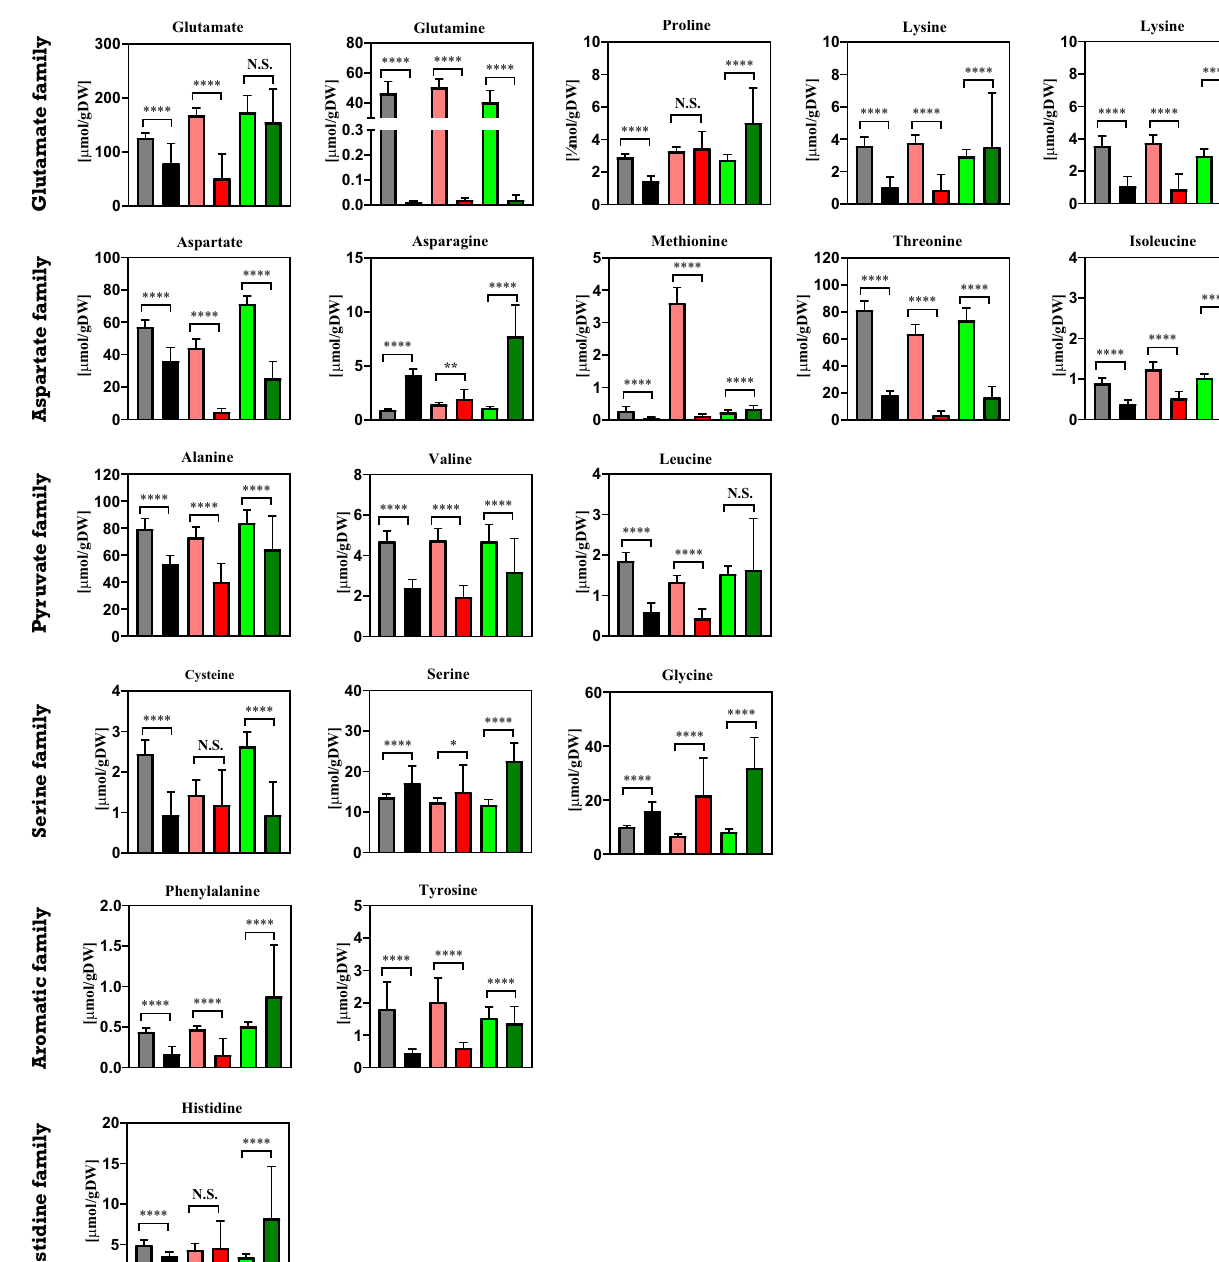
Figure 9. Intracellular amounts of amino acids in Penicillium chrysogenum Wisconsin 54-1255, Penicillium chrysogenum ∆ tps1 and Penicillium chrysogenum ∆ tps2 strains under both steady state conditions and feast/famine conditions. Amino acids were classified into six families, which are derived from the same precursors in the central carbon metabolism. Under steady state conditions, samples were taken at each residence time and datasets were collected from triplicate experiments, while under rapid feast/famine conditions, samples were rapidly taken within a feeding cycle time of 6 min twice for each experiment. The datasets are shown as average value ± standard deviation. The numbers of data points for steady state conditions and feast/famine conditions are 30 and 36, respectively. A two-tailed Student’s t -test was conducted * p < 0.05 (significant) and **** p < 0.01 (extremely significant) vs. WT using GraphPad Prism 8. N.S., not significant; N.A., not available. (cid:122) WT steady state conditions; (cid:122) WT feast/famine conditions; (cid:122) ∆ tps1 steady state conditions; (cid:122) ∆ tps1 feast/famine conditions (cid:122) ∆ tps2 steady state conditions; (cid:122) ∆ tps2 feast/famine conditions. The results from steady state conditions were obtained from Wang et al. (2019)